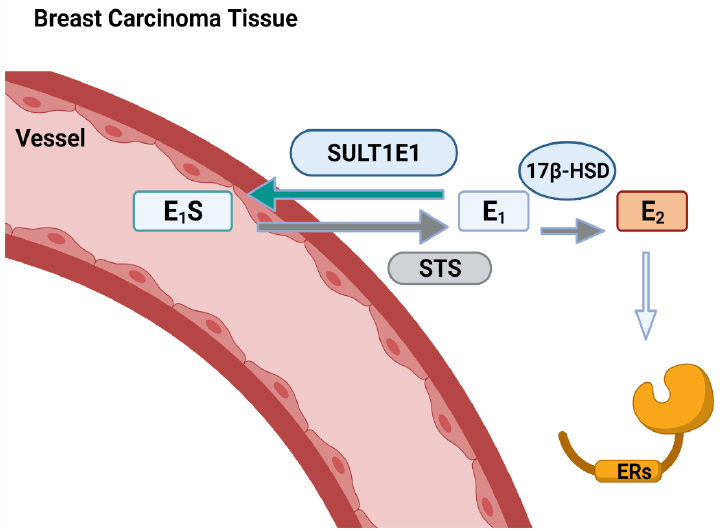
Figure 3. A schematic pathway for estrogen formation by SULT1E1 and STS in breast carcinoma tissue. E 1 S, estrone sulfate; E 1 , estrone; E 2 , estradiol. tissue. E 1 S, estrone sulfate; E 1 , estrone; E 2 ,